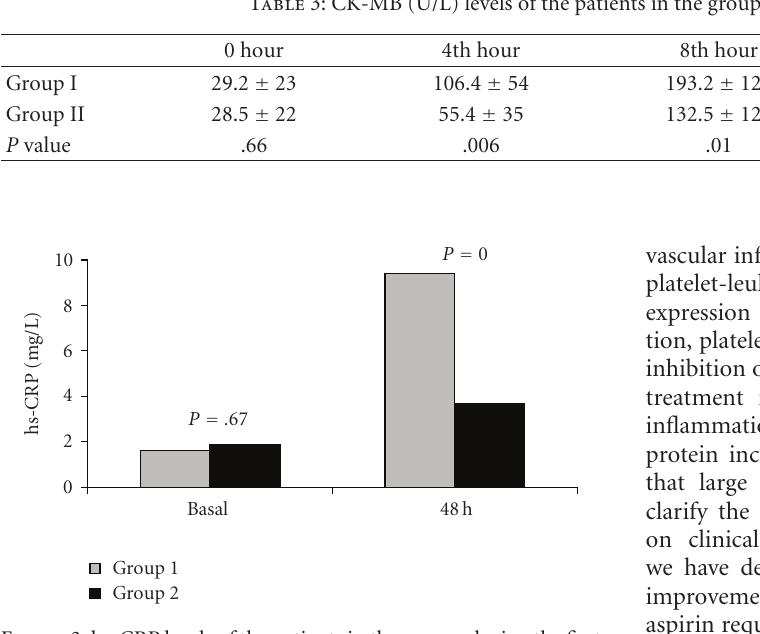
Figure 3: hs-CRP levels of the patients in the groups during the first 48